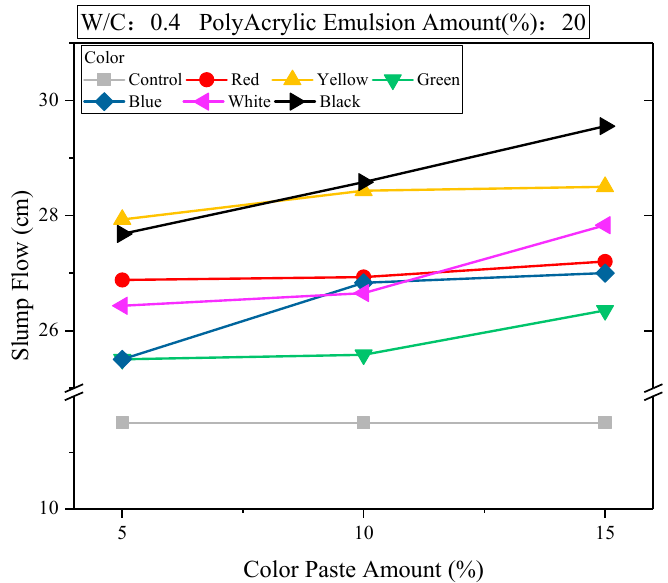
Figure 4. Slump flow of mortar with different proportions of inorganic color paste.